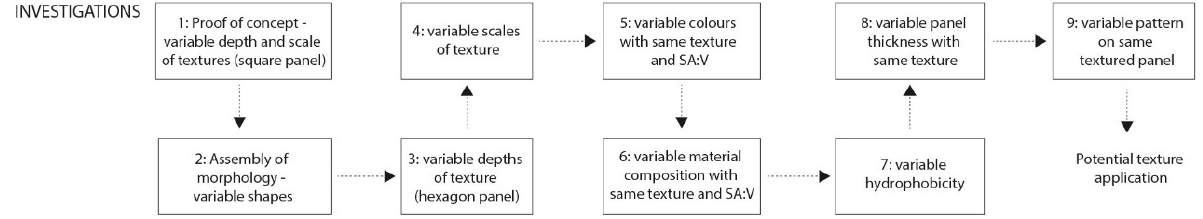
Figure 1. Investigations’ process. This diagram presents the process and sequence of investigations and their relevant examined variables. examined